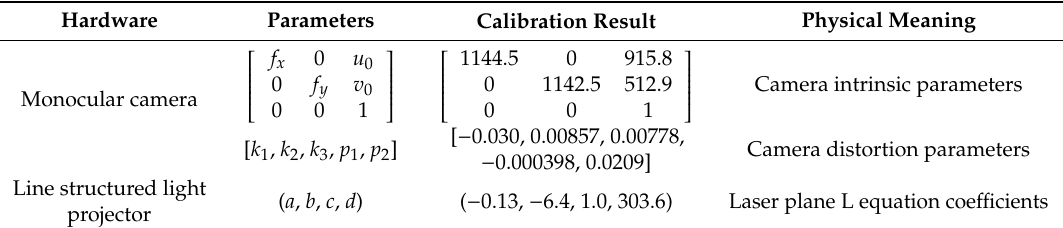
Table 1. Parameters of the